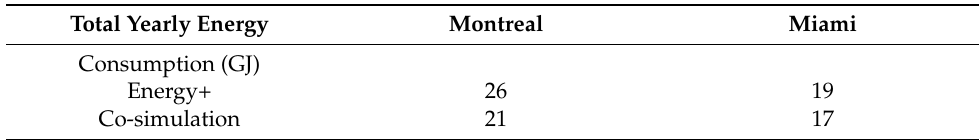
Table 1. Comparison of annual total energy calculated by Energy Plus alone and co-simulated with CONTAM for Montreal and Miami [30].